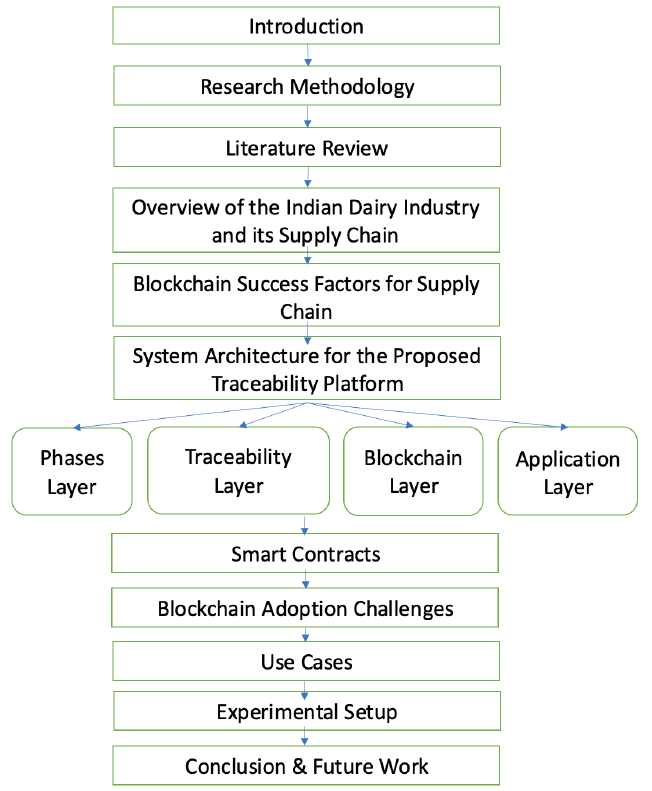
Figure 1. Paper Organization.